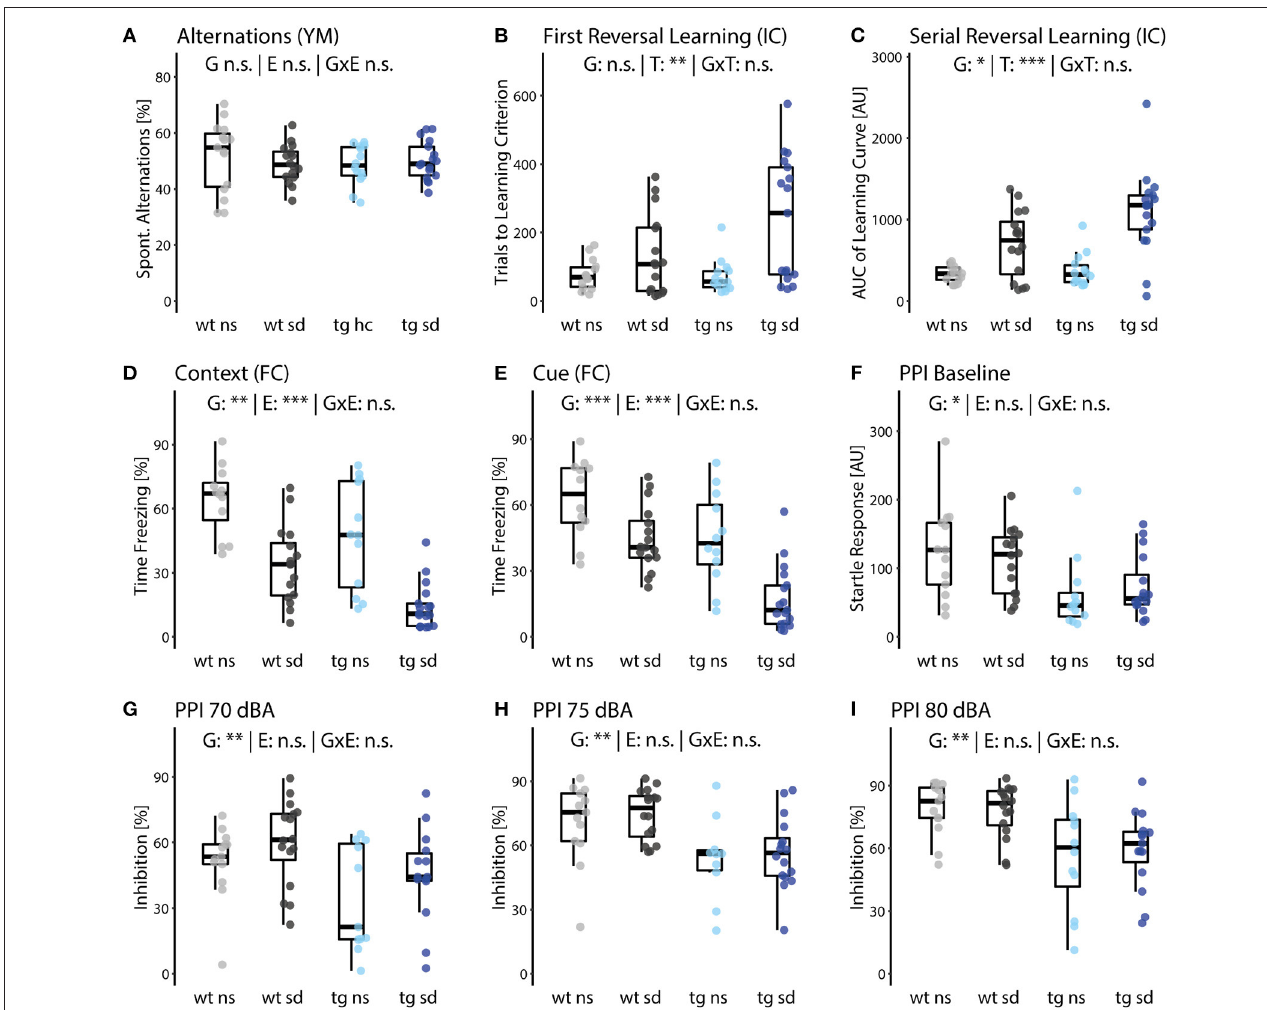
FIGURE 2 | Cognitive deficits but not sensorimotor gating impairments of Tcf4 tg mice are increased by psychosocial stress. (A) The Y-maze test showed no significant differences in spontaneous alternation between groups. (B,C) First [ B ; E: F (1,49) = 11.0, p = 0.0065] and serial reversal [ C ; E: F (1,49) = 29.8, p = 4.47E-5] measures were lower for the social defeat (sd) than for the no stress control (ns) groups, while the genotype effect was only significant in serial reversal [G: F (1,49) = 7.18, p = 0.034]. (D,E) Fear conditioning (FC) revealed a highly significant reduction in contextual [E: F (1,49) = 38.26, p = 6.91E-6] and cued [E: F (1,49) = 22.3, p = 2.8E-4] memory measures in sd, which is additive to a similar reduction in Tcf4 tg mice (tg) compared to wildtype (wt) mice [G: (D) F (1,49) = 13.0, p = 0.0043; (E) F (1,49) = 24.1, p = 2.8.E-5]. (F–I) Pre-pulse inhibition (PPI) measures were not affected by treatment but differed highly significantly between genotypes [G: (F) F (1,49) = 8.37, p = 0.023; (G) F (1,49) = 11.6, p = 0.0058; (H) F (1,49) = 13.9, p = 0.0040; (I) F (1,49) = 15.0, p = 0.0031]. Data are shown as box plots with whiskers extending to no more than 1.5-fold IQR; * p < 0.05, ** p < 0.01, *** p < 0.001, n.s., not significant; p -values are FDR-corrected and refer to Wilk’s lambda testing two-way ANOVA; n = 15/17/15/17. G, genotype term; E, environment term; G × E, interaction term; FC, fear conditioning; PPI, pre-pulse